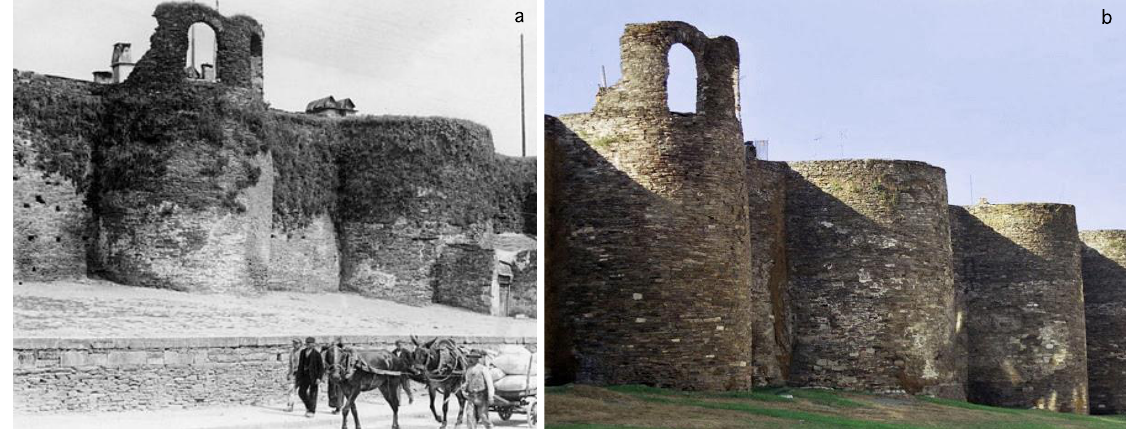
Figure 1. Images of the Roman wall of Lugo. ( a ) Photograph of the structure in 1928 (source: ABC, newspaper); ( b ) a recent photograph of the structure.